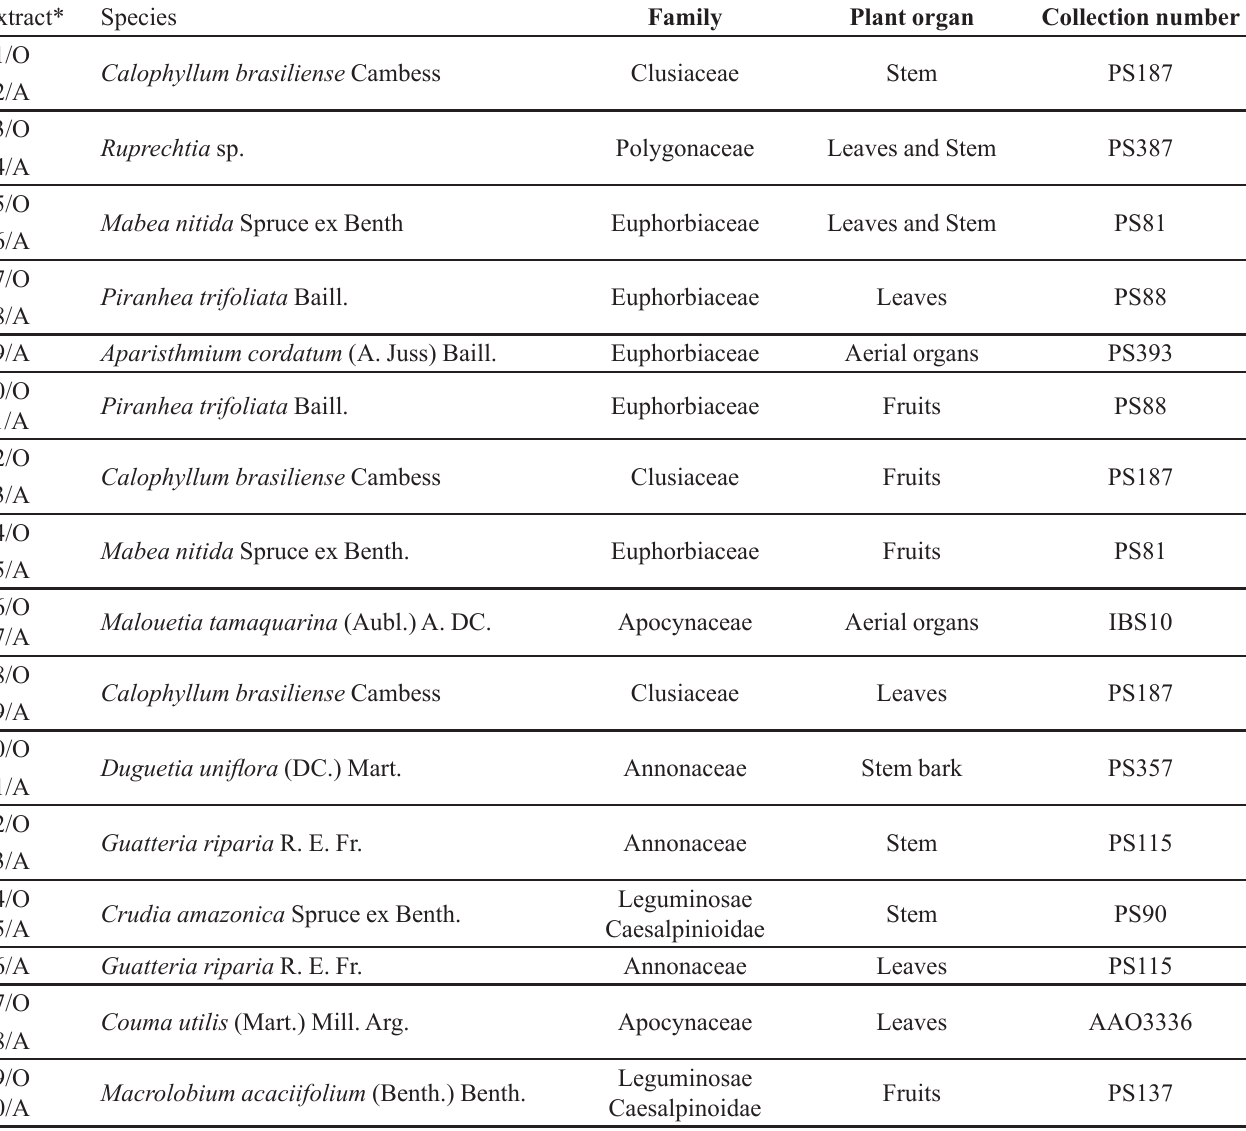
TABLE I - List of Amazonian Rain Forest plant extracts tested against tyrosinase Extract*